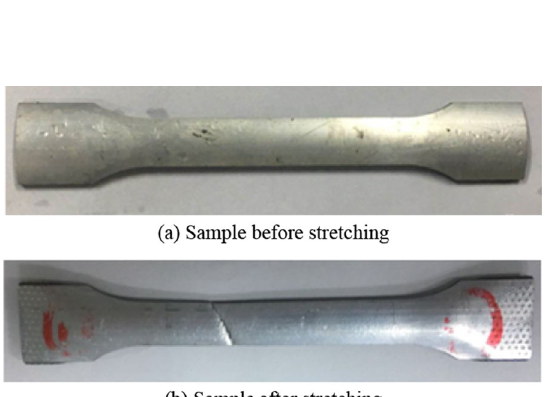
Figure 4 Dimensions of the rectangular tube forming die